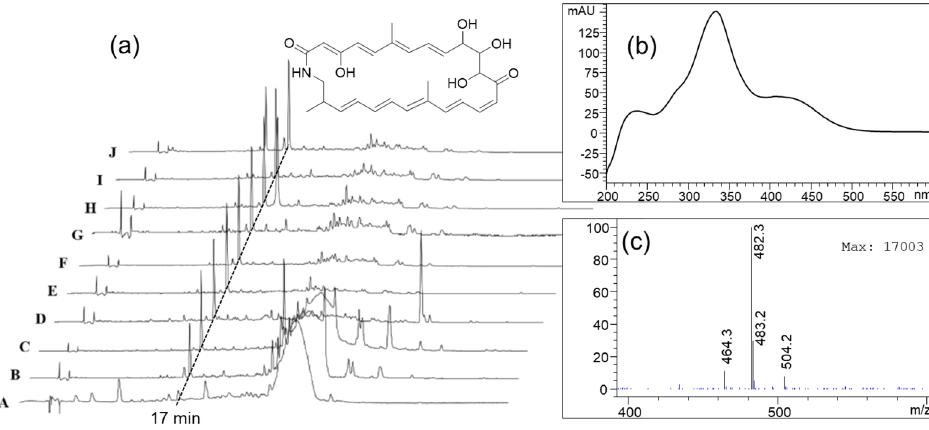
Figure 6. Antifungal compound, sceliphrolactam produced by AT67. ( a ) HPLC chromatograms derived from extracts of culture and inhibition zone (IZ) on agar plates of dual culture between AT67 and fungal strains (A: broth culture of AT67, B: Agar culture of AT67, C: IZ between AT67 and AF1, D: IZ between AT67 and AF2, E: IZ between AT67 and AF5, F: IZ between AT67 and AF6, G: IZ between AT67 and AF7, H: IZ between AT67 and AF9, I: IZ between AT67 and AF10, J: IZ between AT67 and AF11.). UV absorption ( b ) and mass spectrum ( c ) of the peak at a retention time of 17 min (UV maxima at 333 and 420 nm, m/z 482.3 for [M + H] + and m / z 504.2 for [M + Na] + ), indicating sceliprolactam.